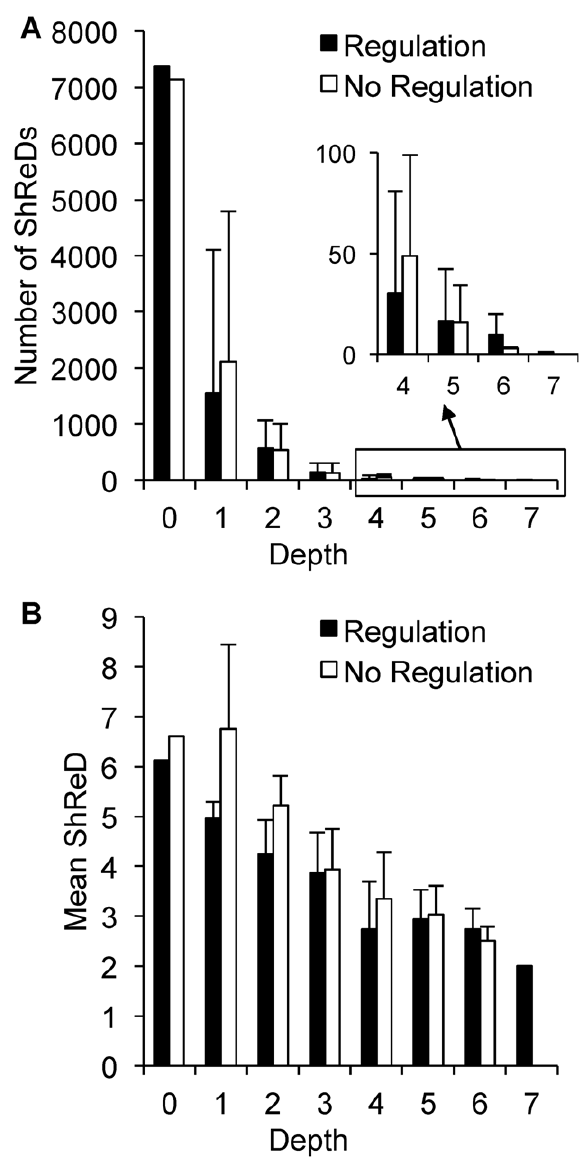
Figure 8. Effects of regulatory edges on module properties. (A) Number of finite ShReDs in a module as a function of partition depth. (B) Average ShReD of a module as a function of partition depth. Error bars represent one standard deviation.